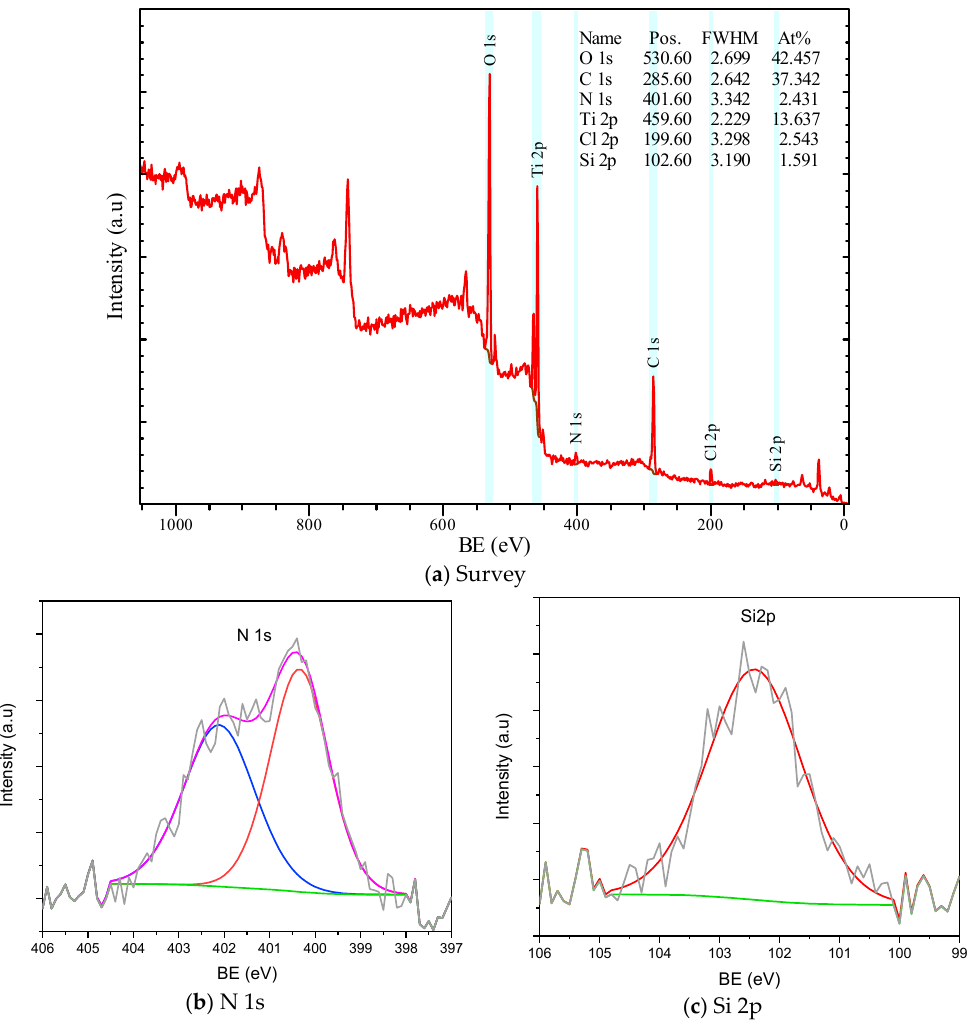
Figure 5. Conventional XPS analysis of an APhTS/TIPT condensed film. ( a ) Survey spectrum with details of surface elements and stoichiometry. ( b ) Characteristic N 1s core level and ( c ) Si 2p core level.